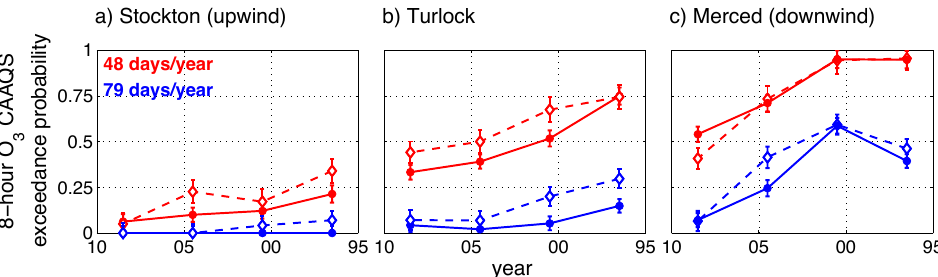
Fig. 9. Northern SJV four-year median 8-h O 3 CAAQS exceedance probabilities vs. year (increasing right to left) are plotted for 1995–1998, weekdays (circles) and weekends (diamonds) for Stockton (a) , Turlock (b) , and Merced (c) . The average number of days with a maximum temperature in each temperature range over the past sixteen years is 48 (high) and 79 (moderate). Error bars are the uncertainties calculated as counting errors and are typically ± 0.04 (1 σ) for weekdays and ± 0.06 (1 σ) for weekends for four-year averages.